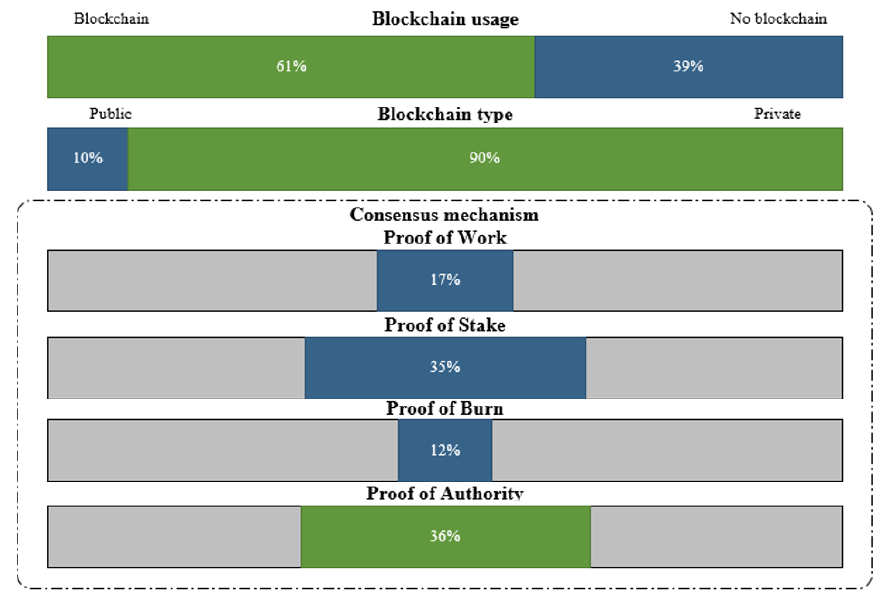
Figure 2. Results of blockchain applicability analysis (available also in